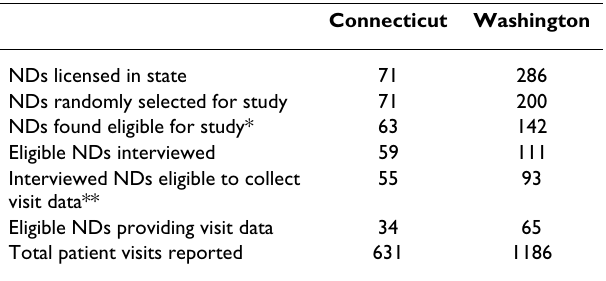
Table 1: Selection and participation of naturopathic physicians (NDs) in Washington (1999) and Connecticut (1998)